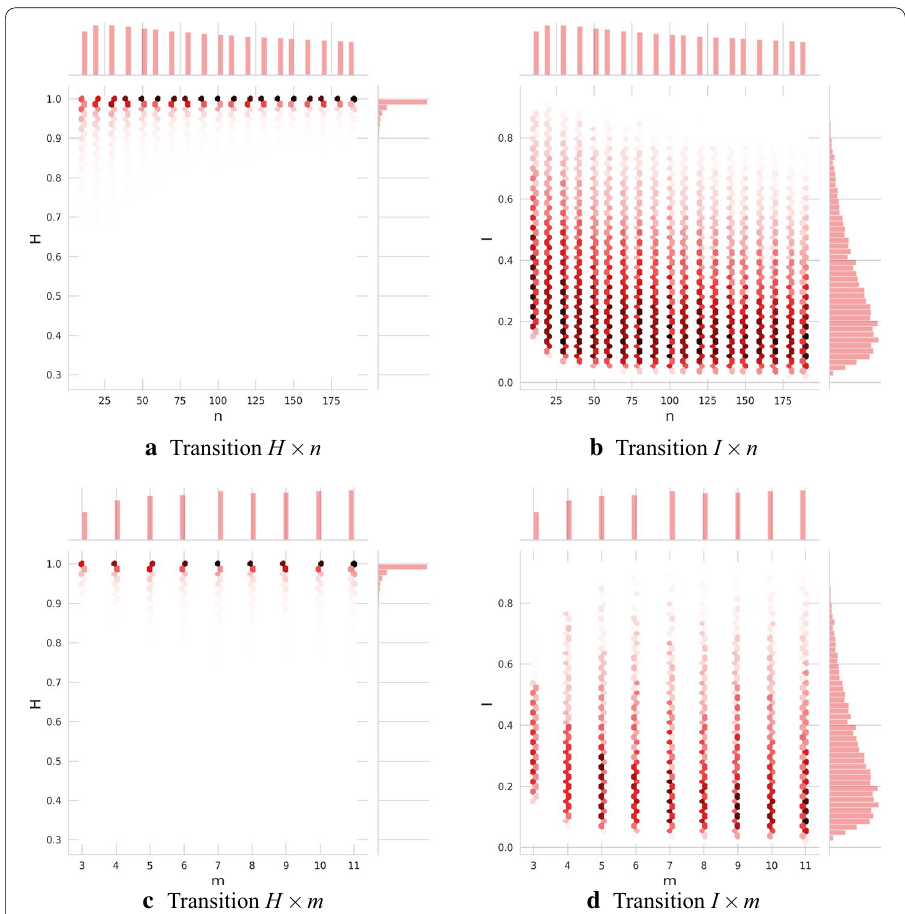
Fig. 19 Dependency on the number of nodes and layers on the transition coupling